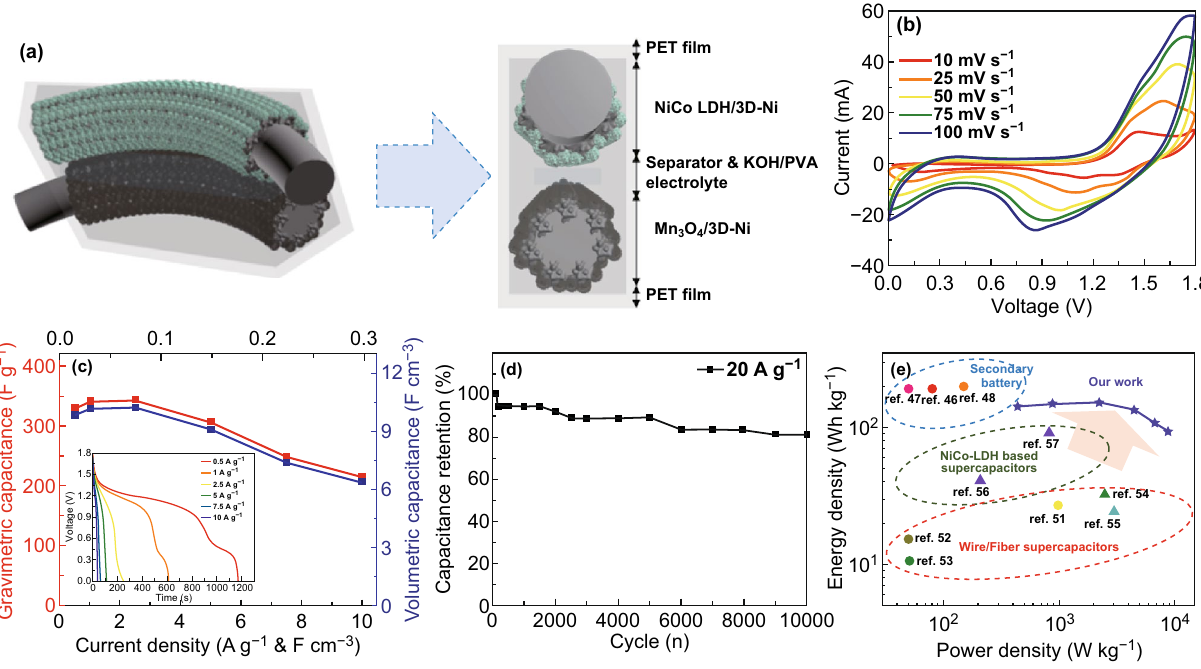
Fig. 3 a Schematic representation of the fabrication of a NiCo LDH/3D‑Ni//Mn 3 O 4 /3D‑Ni hybrid supercapacitor. b CV curves of the hybrid supercapacitor at different scan rates (ranging from 10 to 100 mV s −1 ), and c specific capacitance of the hybrid supercapacitor at different cur‑ rent densities (ranging from 0.5 to 10 A g −1 ) and the inset shows the galvanostatic discharge curves. d Ragone plots of our supercapacitor based on a full cell compared with other electrodes using NiCo LDH and secondary batteries. e Cycling performance of the hybrid supercapacitor for 10,000 cycles at a current density of 20 A g